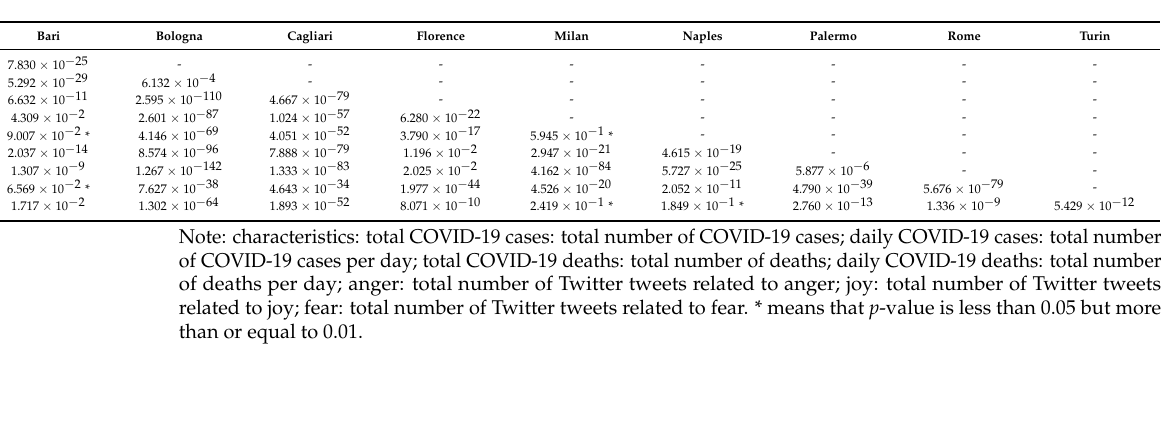
Table 3. Anger p